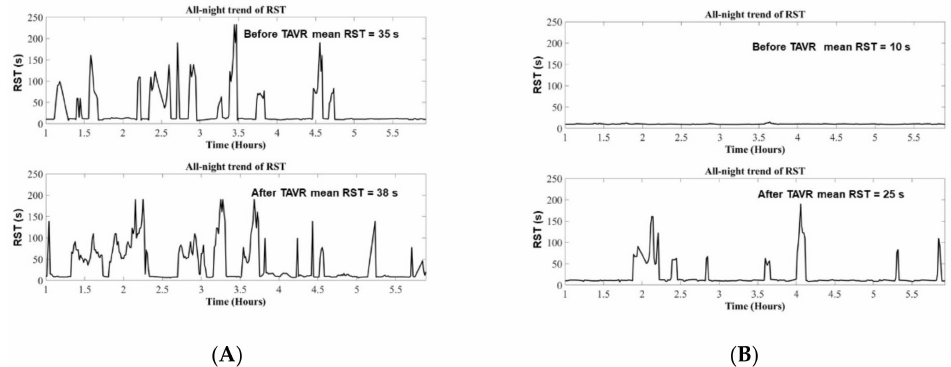
Figure 5. All-night trend of RST in a high RST case ( A ) and in a low RST case ( B ).